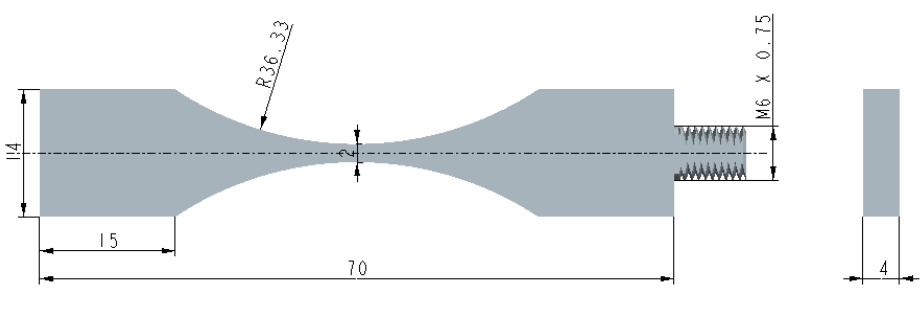
Figure 7. The geometry of the ultrasonic axial loading specimen (unit: mm).